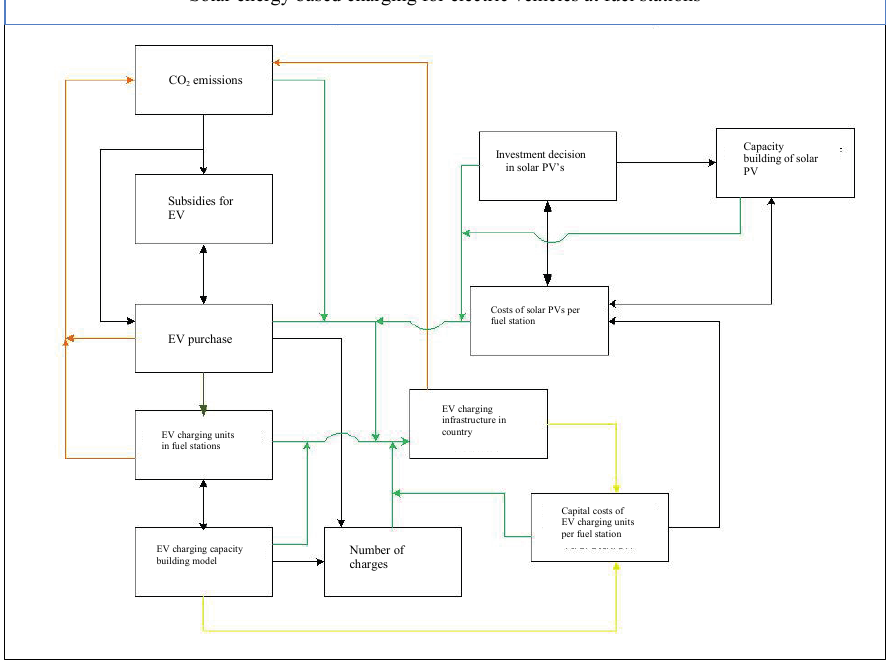
Fig. 2. Sub-models of the main